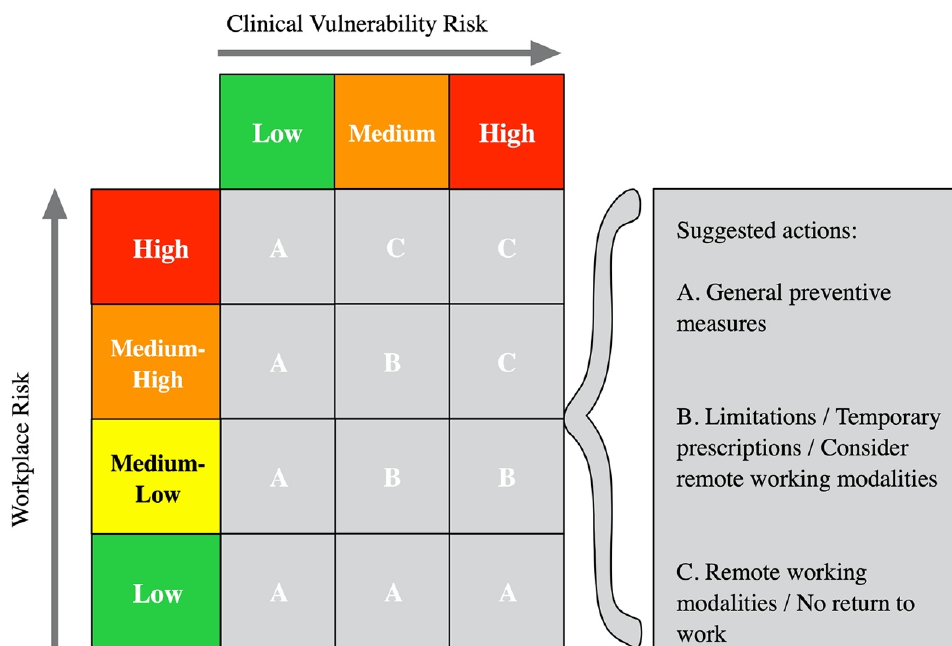
Figure 3. Interpretation of overall health risk (OHR) and suggested actions.